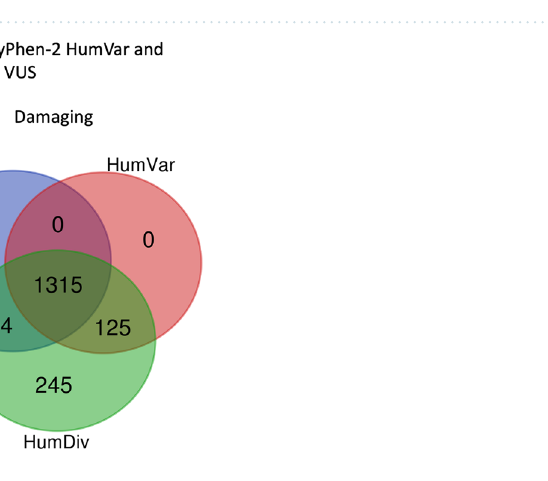
Figure 8. Summary of consensus in prediction outcomes for BRCA2 missense